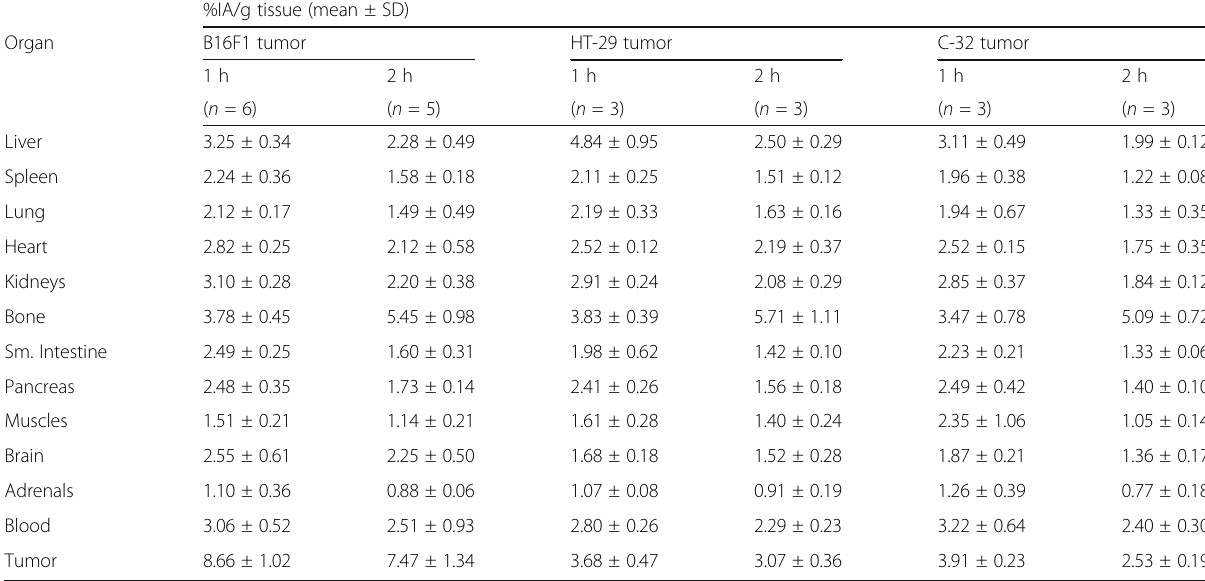
Table 1 Biodistribution of 4-[ 18 F]FEBZA in mice bearing tumor xenografts